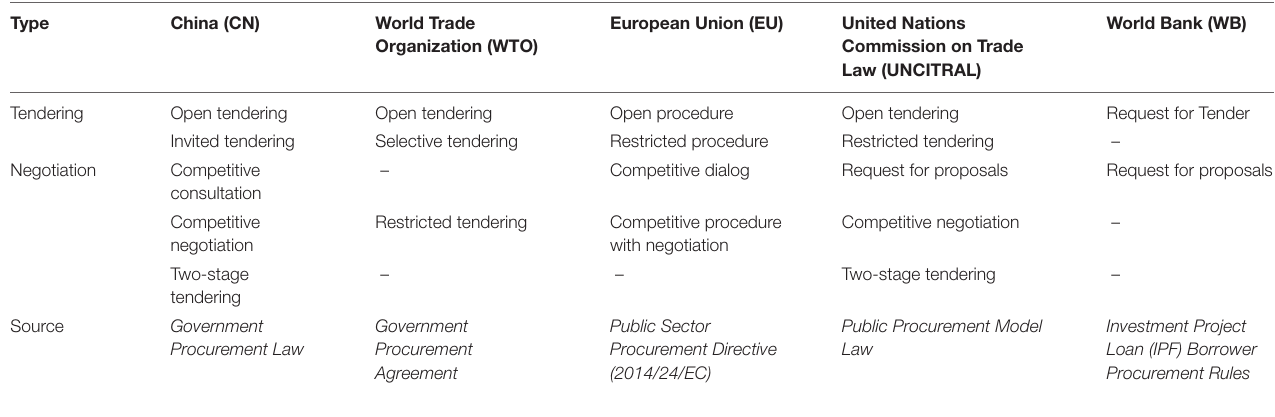
TABLE 1 | Comparison of types of procurement